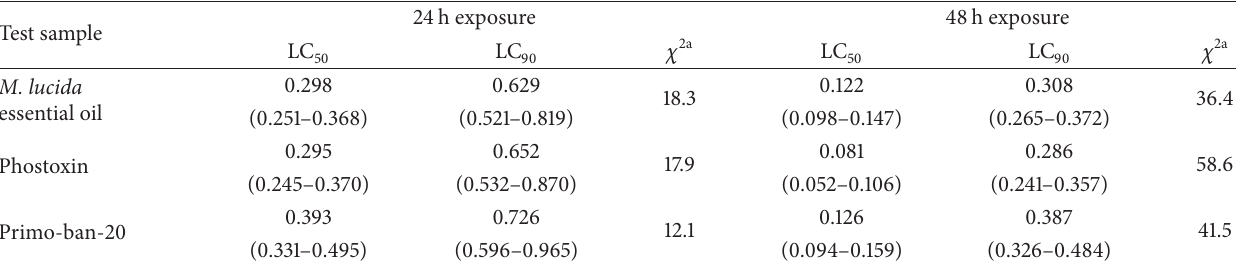
Table 2: Insecticidal activity of M. lucida essential oil against C. maculatus